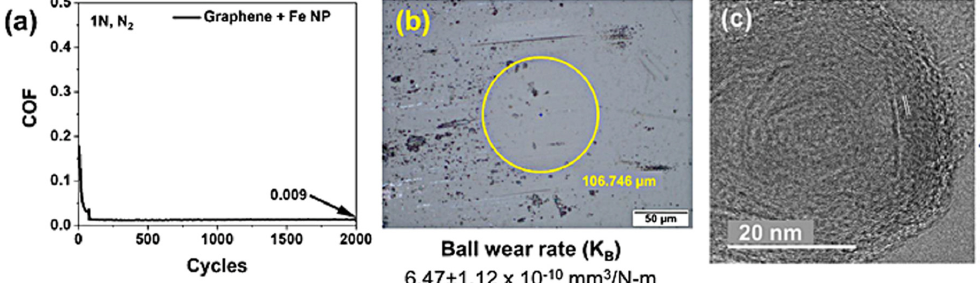
Figure 9. Iron nanoparticles mixed with graphene flakes and sliding against the hydrogenated diamond-like-carbon surface: ( a ) COF (0.0087 ± 0.0008) and ( b ) DLC ball wear diameter and estimated ball wear rate. ( c ) TEM image of wear debris collected from the wear track after 500 wear cycles, revealing a well-formed onion-like carbon nanostructure. Reproduced with permission from [84]. Copyright 2019 John Wiley and Sons.